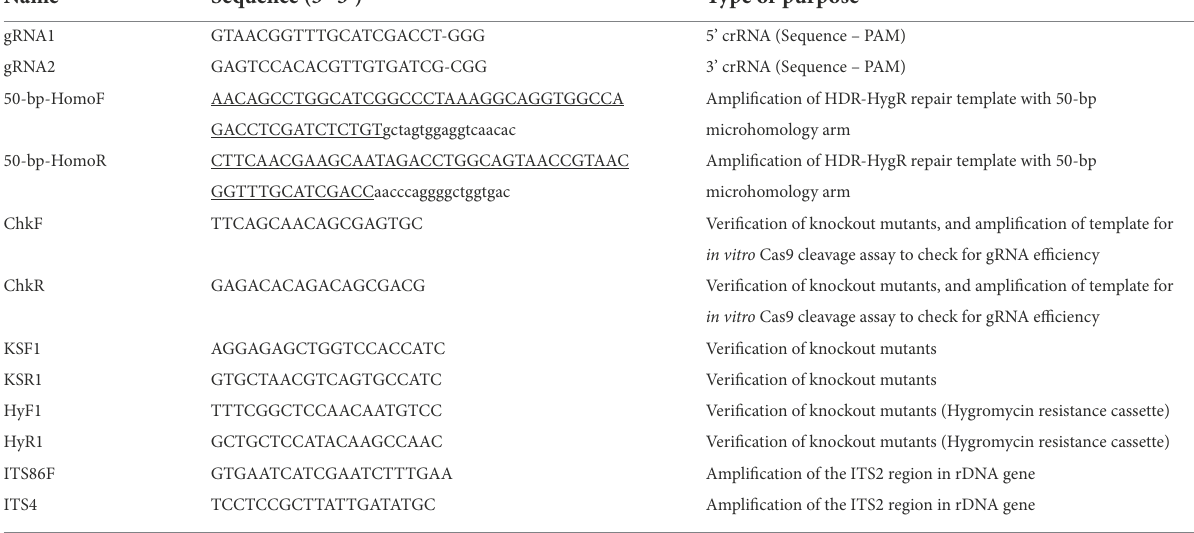
TABLE 1 Primers and oligonucleotides used in this